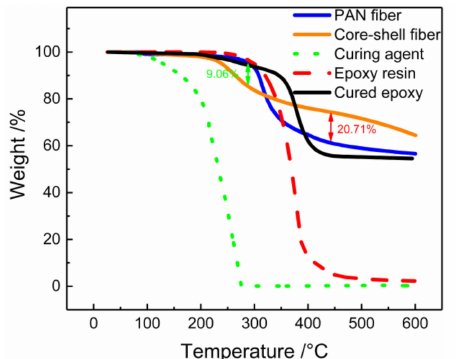
Figure 6. Typical thermogravimetric (TGA) curves for core-shell fiber, PAN fiber, neat epoxy, neat TETA, and cured epoxy.